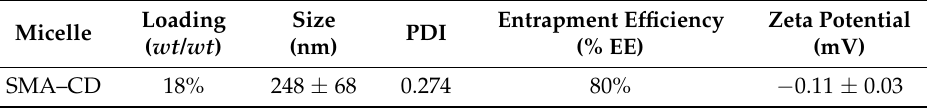
Table 1. Characterization of poly(styrene)-co-maleic acid–(Cu 2+ –curcumin) (SMA–CD) complexes.